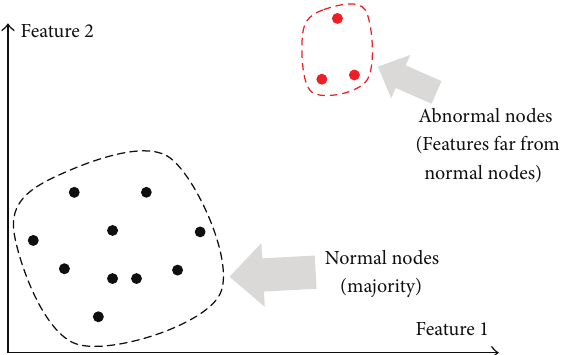
Figure 1: The schematic diagram of KNN intrusion detection